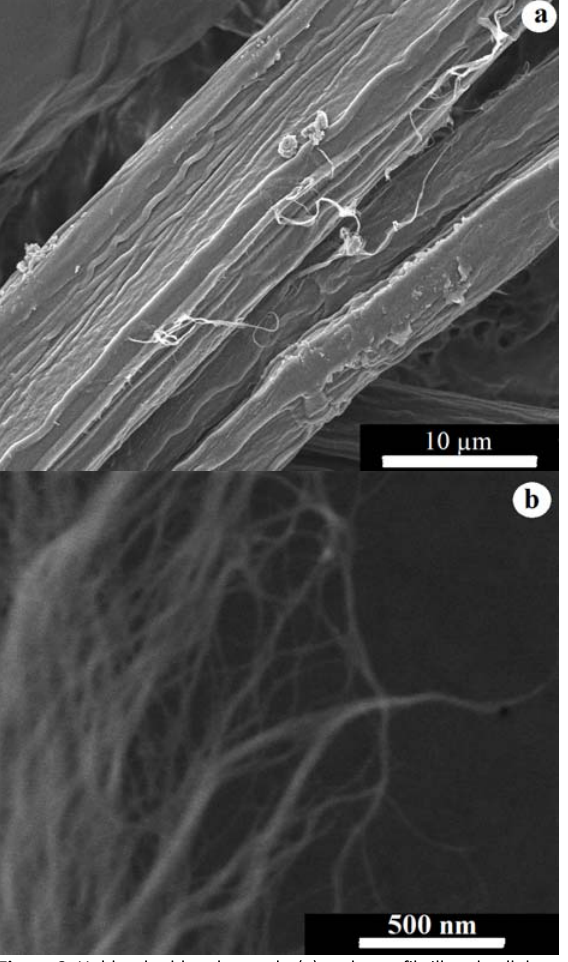
Figure 6. Unbleached bamboo pulp (a) and nanofibrillated cellulose from bamboo pulp after 5 nanofibrillation cycles. Adapted from